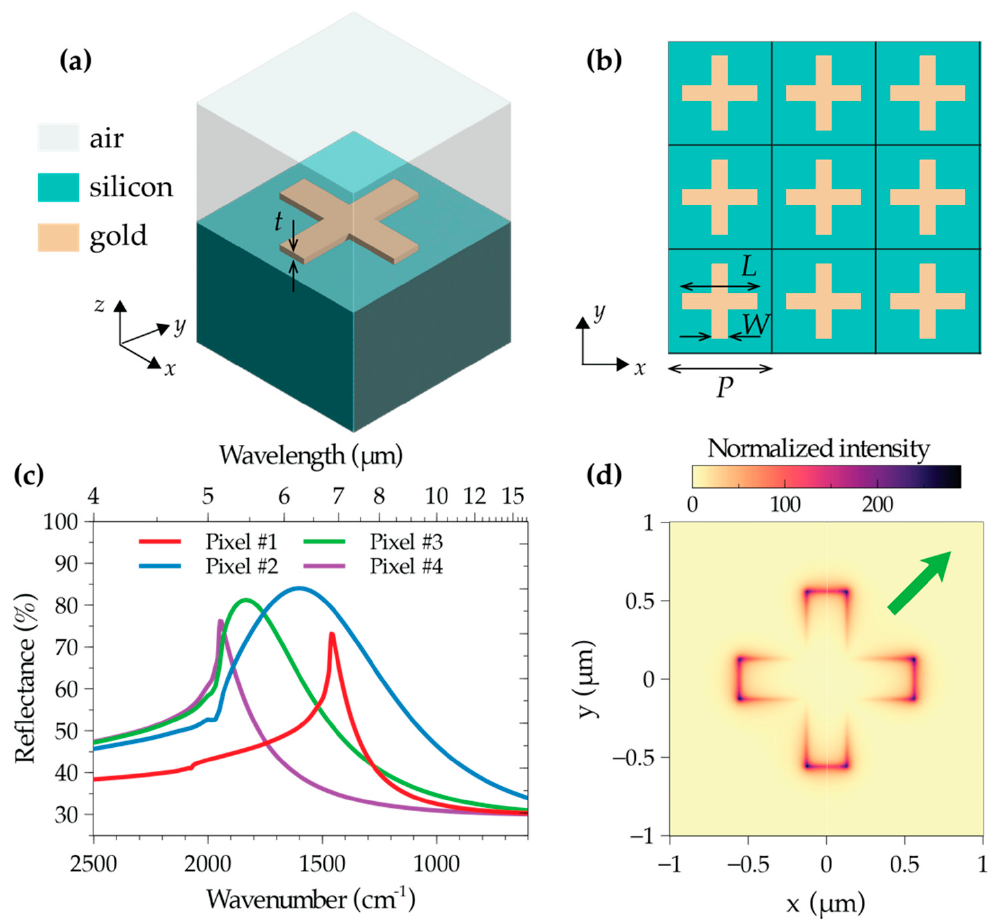
Figure 1. MS modeling and design. ( a , b ) Schematic of unit-cell and periodic array (top view), respectively. ( c ) Numerically computed reflectance responses, for plane-wave illumination with normal incidence and x -polarized electric field, and four representative parameter configurations (pixel #1: p = 2.0 µ m, L = 1.117 µ m, W = 0.255 µ m; pixel #2: p = 1.5 µ m, L = 1.247 µ m, W = 0.267 µ m; pixel #3: p = 1.5 µ m, L = 1.027 µ m, W = 0.270 µ m; pixel #4: p = 1.5 µ m, L = 0.843 µ m, W = 0.250 µ m). ( d ) Intensity distribution (electric field, normalized with respect to the impinging one) within a unit-cell, for pixel #1, computed 10 nm away from the nanoantenna at the resonant wavenumber 1457 cm − 1 . The thick green arrow indicates the polarization of the impinging electric field (not aligned to the cross arms, for better visualization).